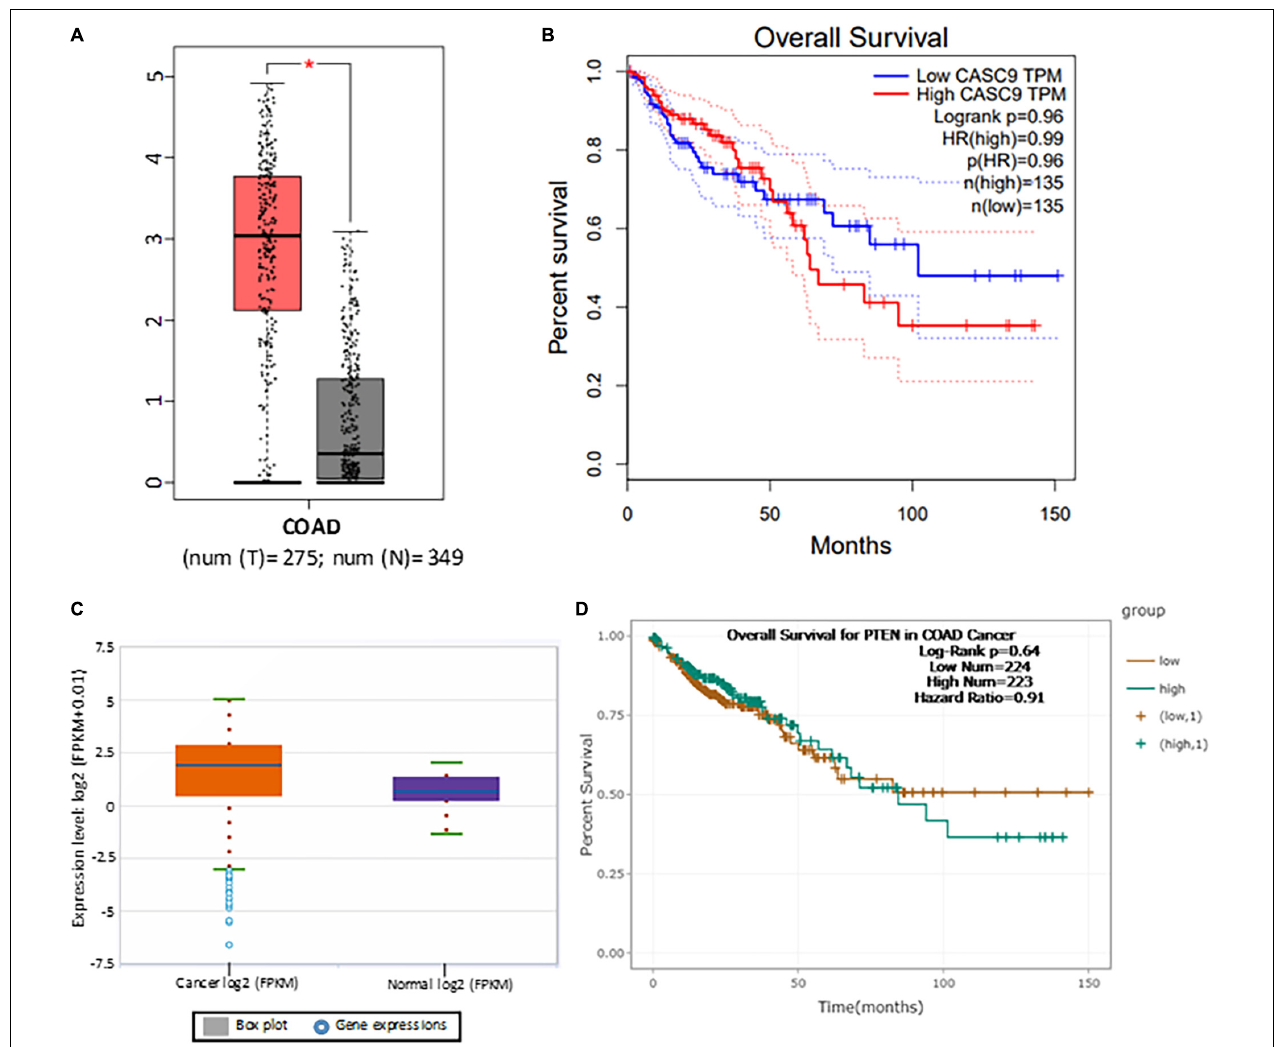
FIGURE 1 | CASC9 overexpression is correlated with poor survival in CRC. (A) Boxplot CASC9 expressions of CRC tissues ( n = 275) compared with normal samples ( n = 349) from TCGA-COAD dataset (http://gepia.cancer-pku.cn/detail.php) showing that CASC9 was significantly upregulated in CRC tissues with a Log2FC cutoff value 2.0 and P < 0.01 (*). (B) The expression profiles, number of TPM, and HR (%) were used to plot overall survival. Higher expression of CASC9 in CRC tissue is associated with poor overall survival. (C) CASC9 expression was extracted from ENCORI-COAD dataset (Li et al., 2013). Four hundred seventeen tumor samples and 41 normal tissues were used from the dataset. Boxplot analysis showed that CASC9 was upregulated in tumor tissues. (D) The log-rank P < 0.05, HR, and high/low expression numbers were used to plot survival curve from ENCORI-Pan-Cancer. Higher expression of CASC9 reduced the overall survival of patients. TCGA, The Cancer Genome Atlas; COAD, colon adenocarcinoma; ENCORI, The Encyclopedia of RNA Interactomes; TPM, transcript per million, HR, hazard